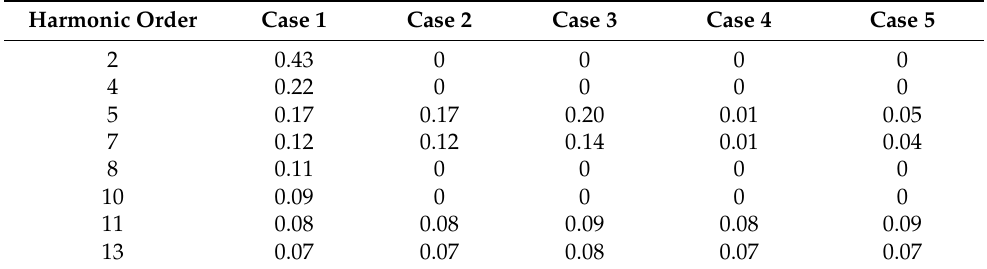
Table 3. Spatial harmonics in the winding distributions of the considered cases.